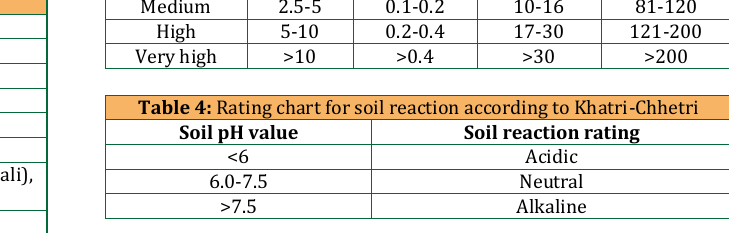
Table 1 : Basic information of the study Design :